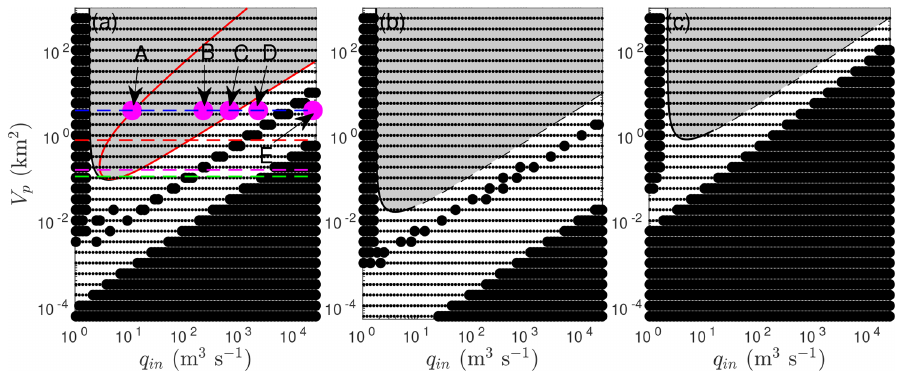
Figure 8. The stability boundaries of Fig. 2 with L = 50km (a) , 250km (b) and 10km (c) plotted as black lines; unstable regions in the lumped model (2) are marked in grey. Solid black circles indicate parameter combinations for which the steady-state solution to the full model (1) is stable, and small dots indicate that the full model is unstable. The magenta markers in panel (a) indicate parameter values for which the evolution of the full, spatially extended model has been computed up to finite amplitude (Figs. 9–11). The red curve in panel (a) is the same boundary as in Fig. 7, indicating where negative effective pressures are encountered in the lumped model. The dashed, coloured horizontal lines in (a) show the values of V p used in Fig. 5, using the same colouring scheme as the periodic orbits in the latter figure.